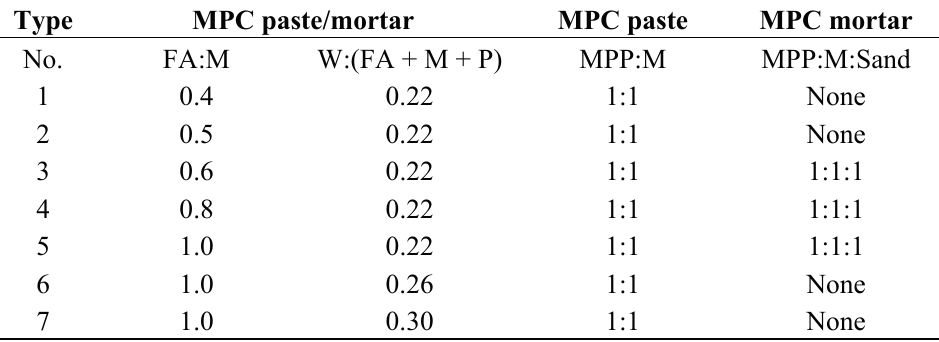
Table 1. Mix proportions of MPC paste and mortar (mass